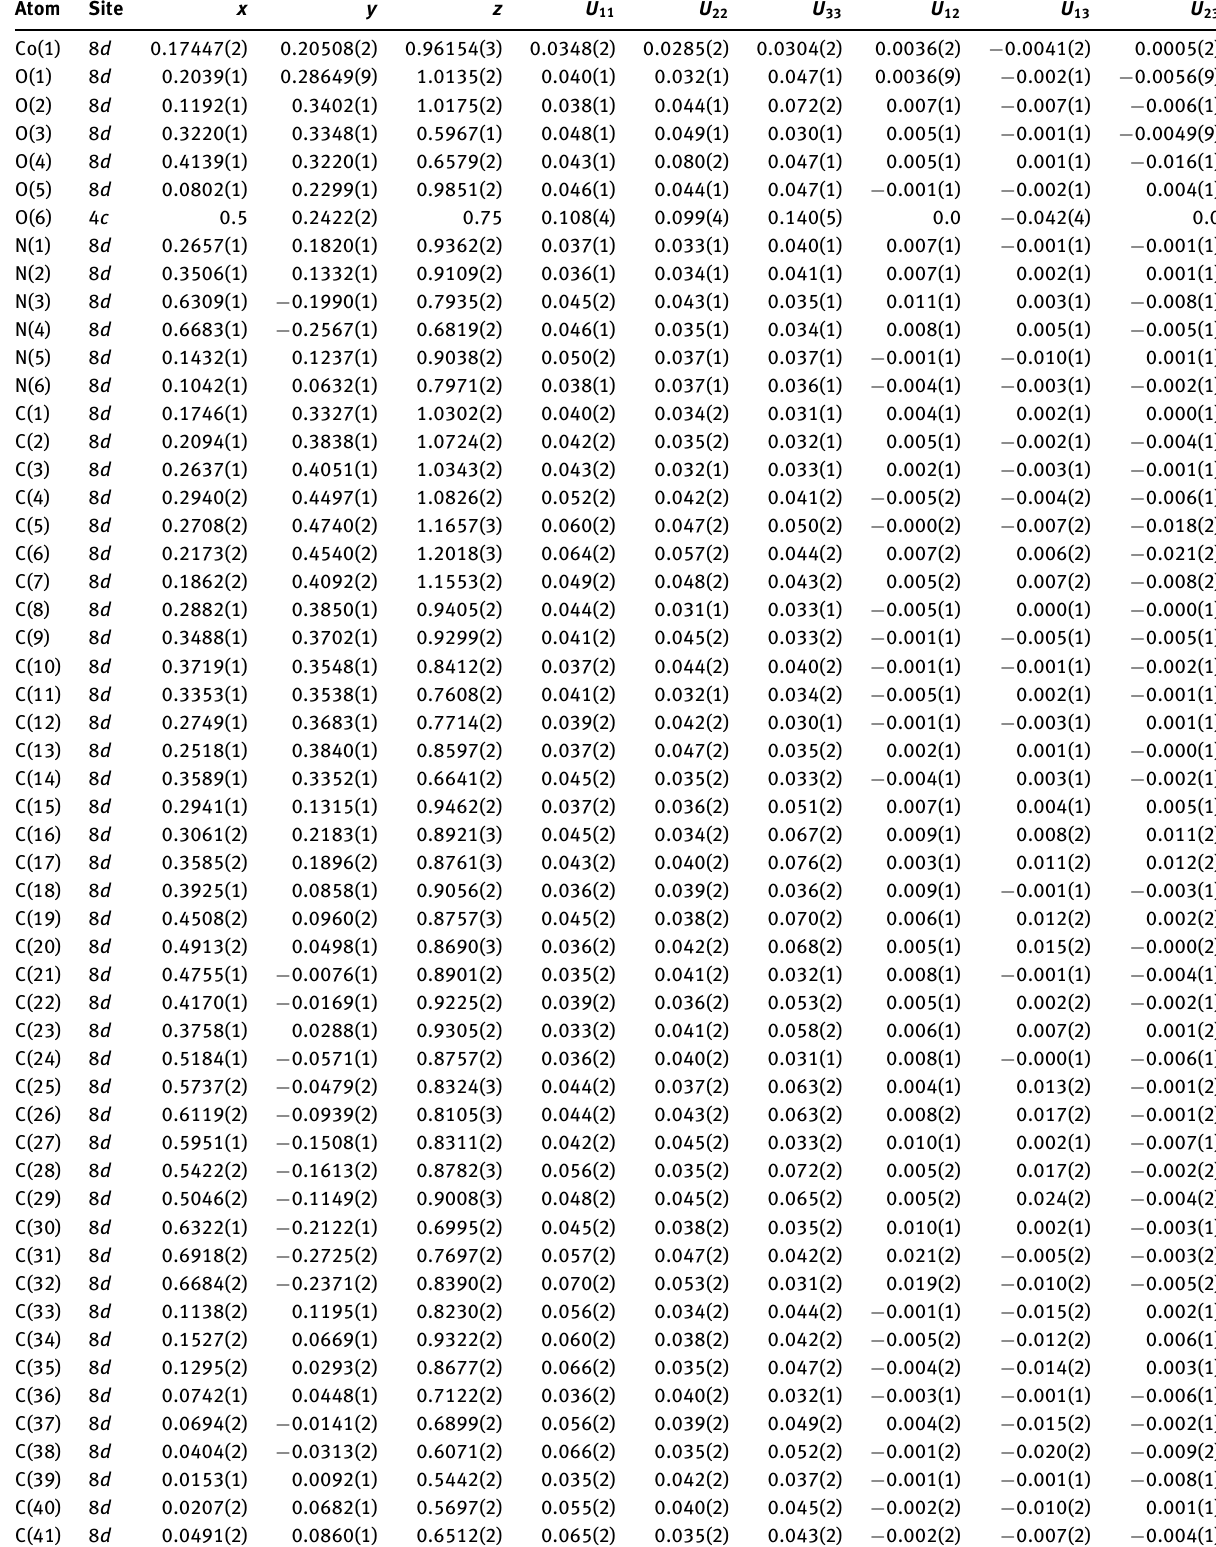
Table 3: Atomic displacement parameters (Å 2